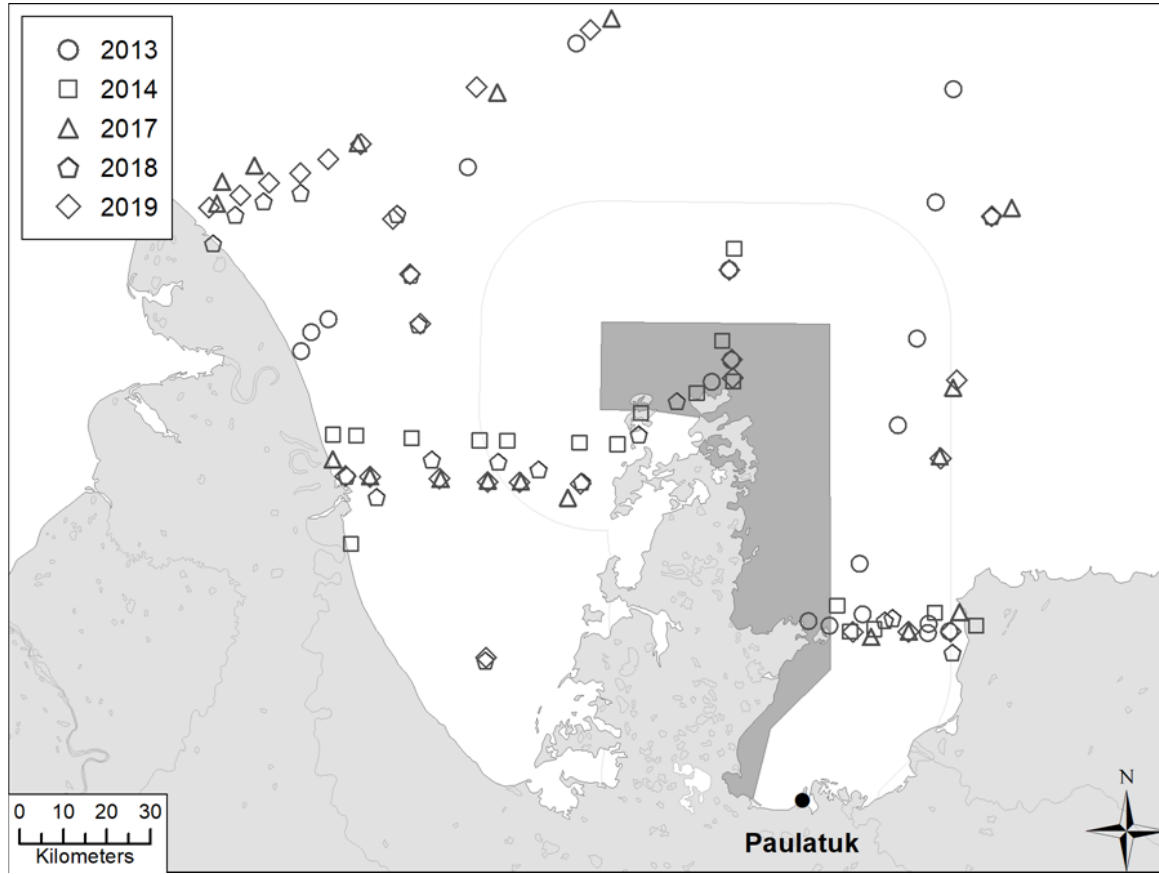
Figure 7. Stations sampled within the vicinity of the ANMPA during the consecutive ecosystem assessment programs conducted from the F/V Frosti: BREA MFP (2013), BSMFP (2014), and CBS MEA (2018–2019). Station sampling typically included full profiles for physical and chemical oceanography, water sampling for nutrient concentrations and primary production, zooplankton biodiversity, bottom sediment characterization, and bottom trawling for fish and benthic invertebrate biodiversity. Continuous hydroacoustic observations of fish and zooplankton aggregations in the water column were recorded along the ship track (not shown). A 15 nm radius around the ANMPA is shown in light grey. Map created by M.